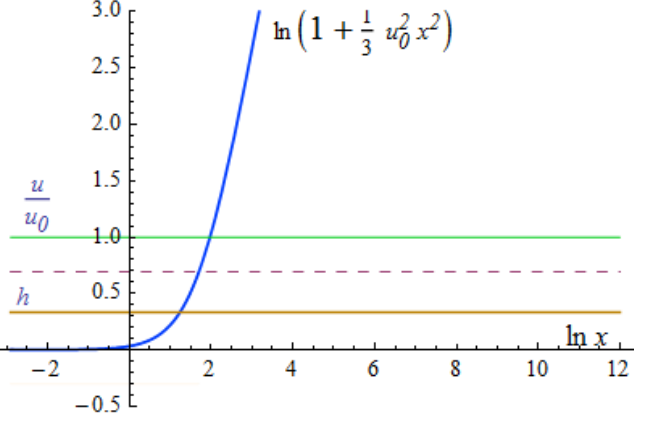
2 (cid:18) (cid:19) 2 x g x g = u 2 = 0 : 1 ; = 1 : = u 2 = 0.1, = 1. A logarithmic g 0 x g max g x g max 0 (cid:16) (cid:17) u 2 x 2 = 3 0 u 2 x 2 = 0 : 1 + 1 0 3 (cid:0)